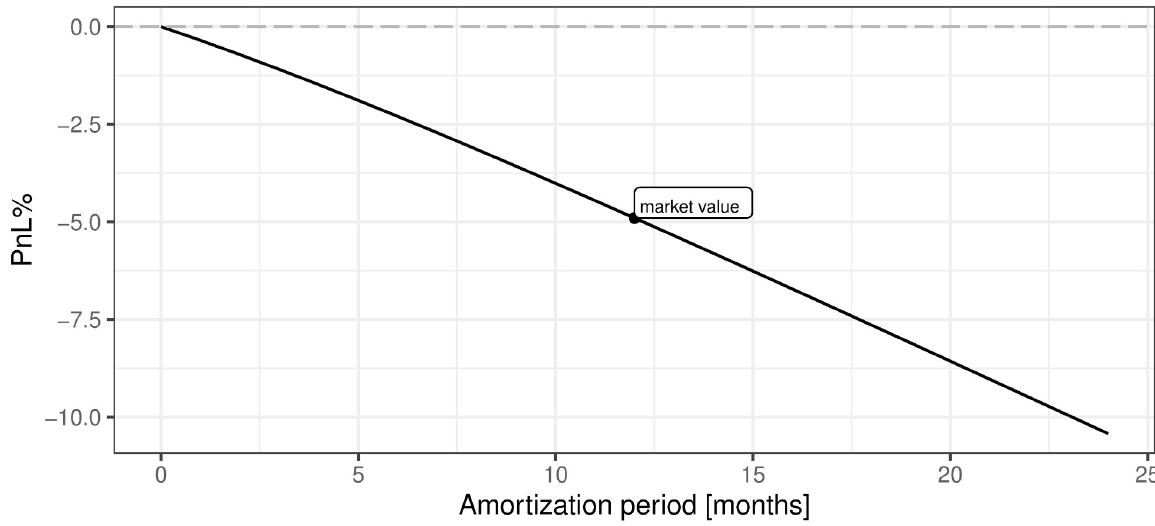
Fig 25. BTC mining profitability (PnL%) for different levels of amortization period. Note: PnL%, calculated according to the formula 6. Hypothetical amortization periods range from 0 to 24 months. Other parameters are assumed as outlined in the section Values of variables as of 2021/12/03. Source: own calculations based on data described in section Crucial assumptions and data.